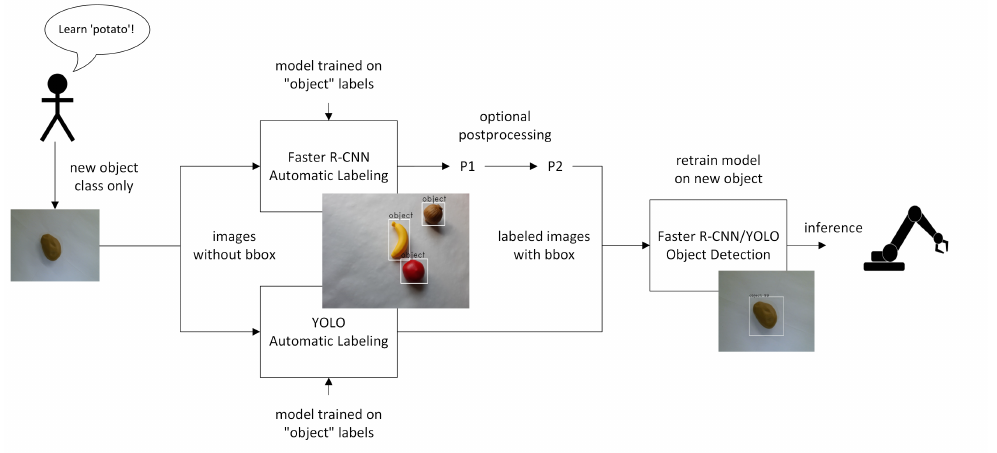
Figure 1. Overall workflow of object registration. A human operator initiates the training of a new object by only presenting the new object and providing the label without bounding boxes. Without any further human intervention, bounding boxes are then inferred by models trained on images using only an “object” label. Optionally, additional post-processing is applied which consists of the two steps (P1) and (P2) for merging of multiple bounding boxes and slightly increasing bounding boxes (see Section 3.2 for a detailed description). The training images with these automatically inferred bounding boxes are used to train the final object detection